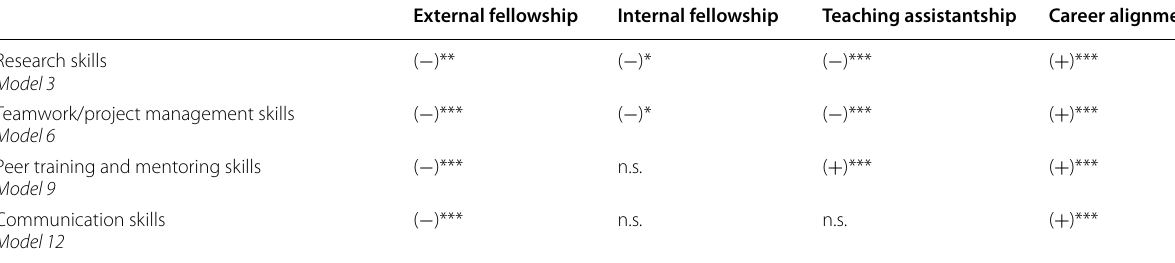
( ) indicates a negative regression coefficient and ( − n.s. not